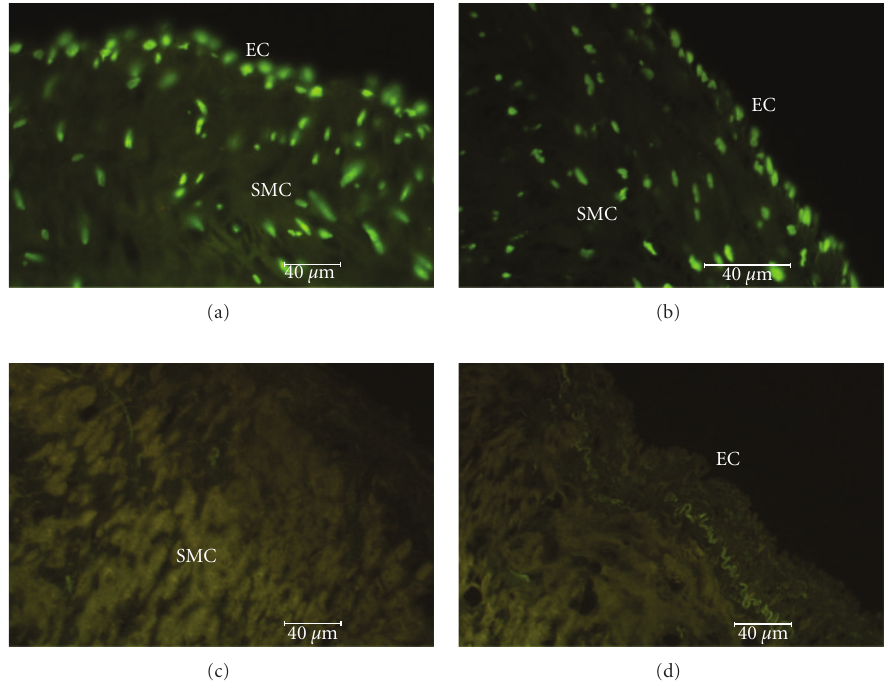
Figure 6: Apoptotic smooth muscle cells (SMCs), and endothelial cells (ECs). Group II (a) and Group III (b). (c) and (d) represent negative controls (Group